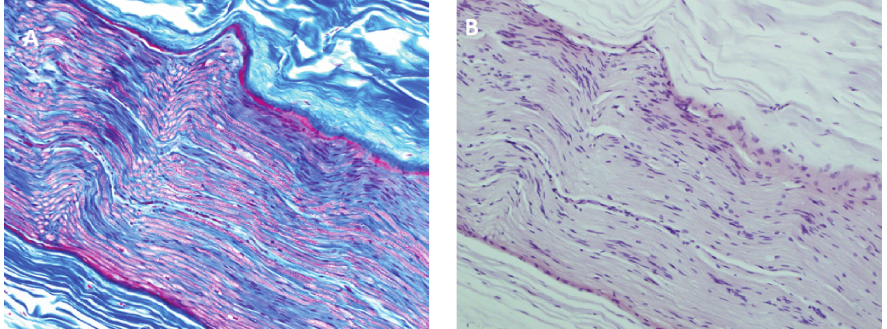
Figure 4: Phrenic nerve. (A) Trichrome staining of right phrenic nerve showing preservation of myelin sheath, 400x. (B) Congo red stain of right phrenic nerve, negative for amyloidosis,